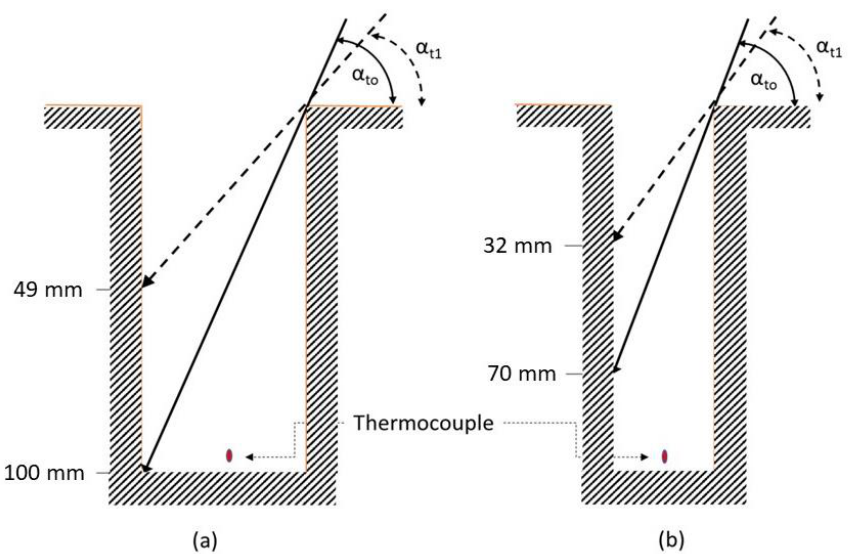
Figure 2. Schematic diagram depicting maximum direct radiation penetration into vertical, cylin- drical burrows with diameters of 17 mm ( a ) and 11 mm ( b ). During the three measurement days (16, 17, and 18 June) described in the text. Computed sun elevation angles immediately after removal of trapdoor (α to ) and before replacement (α t1 ).